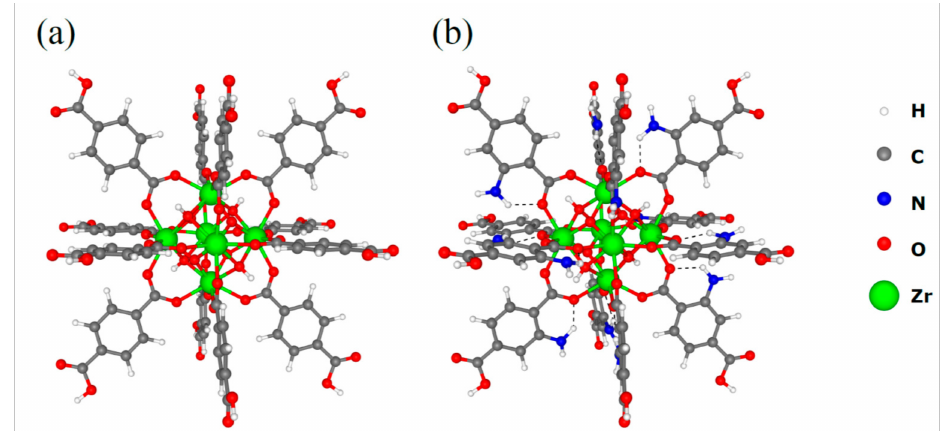
Figure 8. Optimized structures of ( a ) UiO-66 and ( b ) UiO-66-NH 2 . Dashed lines indicate hydrogen bonding between O and H atoms. O atoms with and without hydrogen bonding in the metal cluster possess 6.90e and 6.71e,